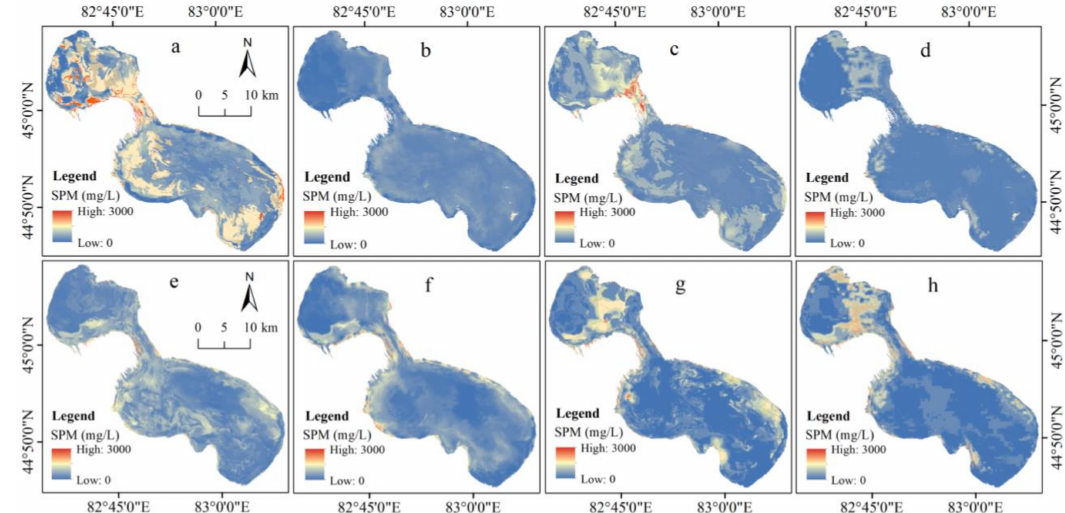
Figure 14. Results of the “inversion first” strategy: ( a ) RF (Landsat 8)_ESTARFM; ( b ) RF (Landsat 8)_FSDAF; ( c ) XG- Boost (Landsat 8)_ESTARFM; ( d ) XGBoost (Landsat 8)_FSDAF; ( e ) RF (Sentinel 2)_ESTARFM; ( f ) RF (Sentinel 2)_FSDAF; ( g ) XGBoost (Sentinel 2)_ESTARFM; ( h ) XGBoost (Sentinel